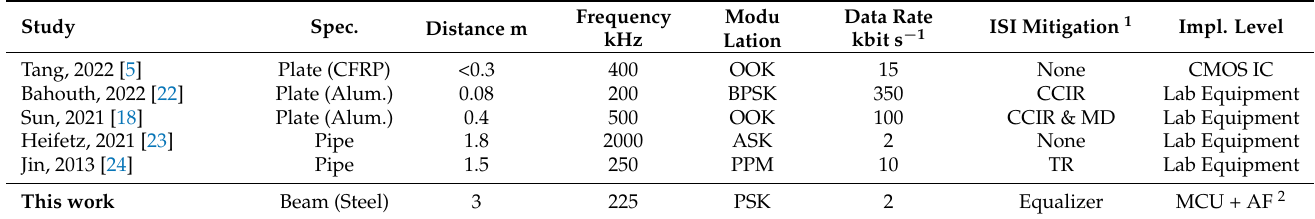
Table 2. Summary of existing studies on lamb-wave-based active communication studies compared to the presented backscatter communication